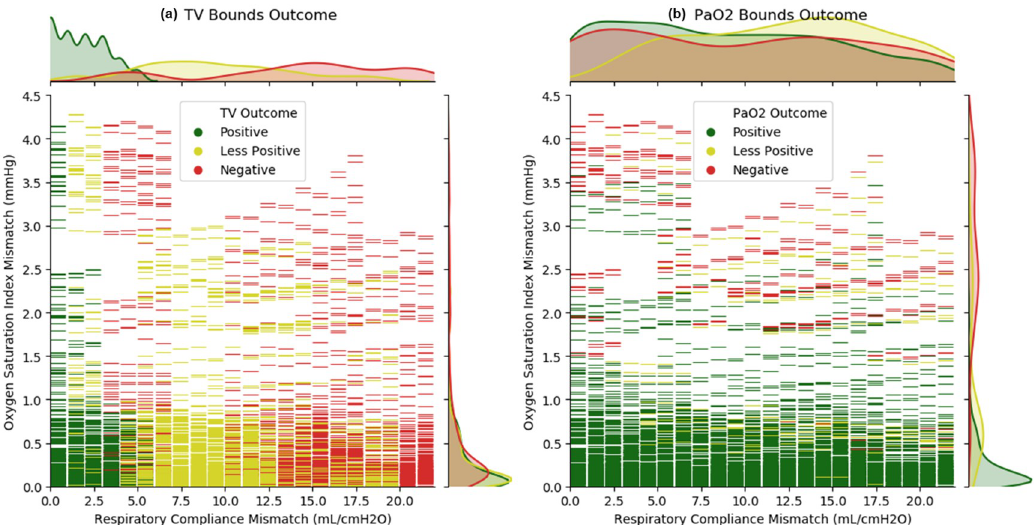
Fig 4. Comparison of multi-patient ventilation simulated outcomes due to TV (plot a) and PaO 2 (plot b) outcome bounds. Each graphical dash is a full simulation. Included are univariate histogram plots for each axis using kernel density estimation to represent the distribution of all three outcomes described in two dimensions. The compliance (abscissa) has discrete values due to the chosen patient model parameter setting methodology and fluid mechanics. The OSI (ordinate) is dependent on all external settings, along with the complex interactions of internal mechanistic models. Note that while the OSI has units of mmHg (because it is a ratio of pressure divided by saturation), the interpretation is like the unitless OI value.